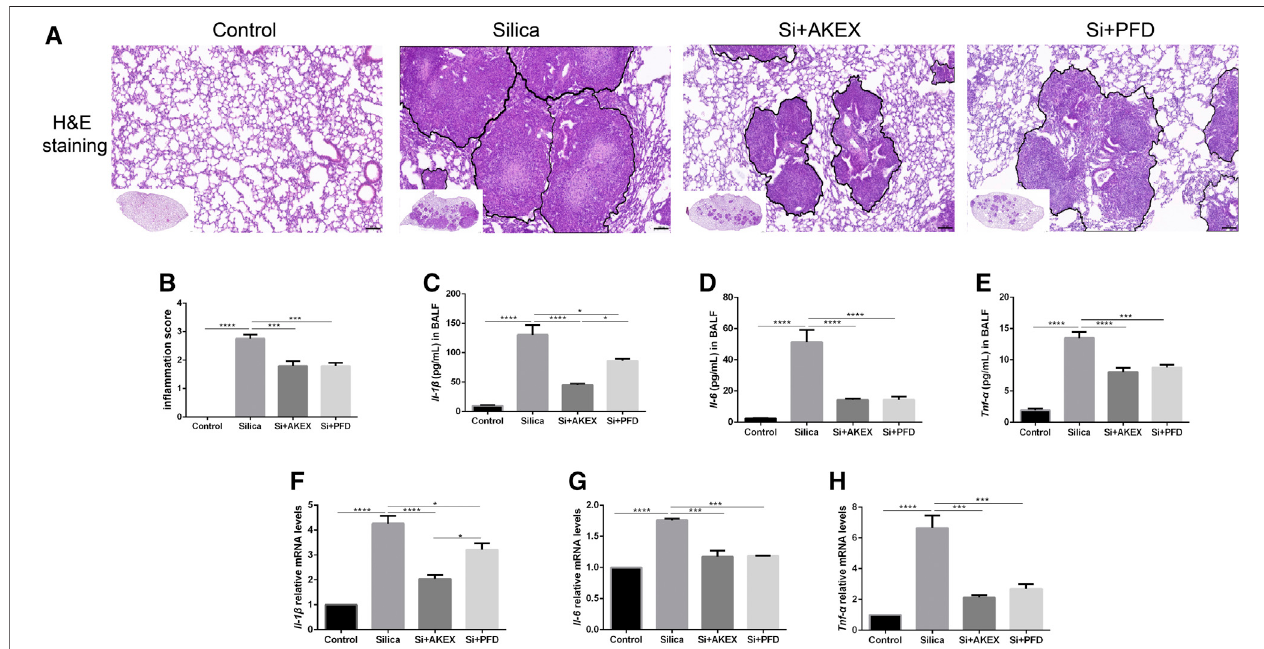
FIGURE 2 | AKEX0011 reduced in fl ammation in the early therapeutic silicosis model. (A) H&E staining of lung sections (original magni fi cation ×100). (B) In fl ammatory score (based on H&E staining) (n = 5). (C-E) In fl ammatory cytokines in the BALF (IL-1 β , IL-6, and TNF- α ) measured by ELISA (n = 5). (F-H) Levels of in fl ammatorycytokines(IL-1 β ,IL-6,andTNF- α )inlungtissuesmeasured byqPCR(n=3-4).Alldatawerepresented asmean±SEM;* p < 0.05,** p < 0.01,*** p < 0.001, and **** p < 0.0001.